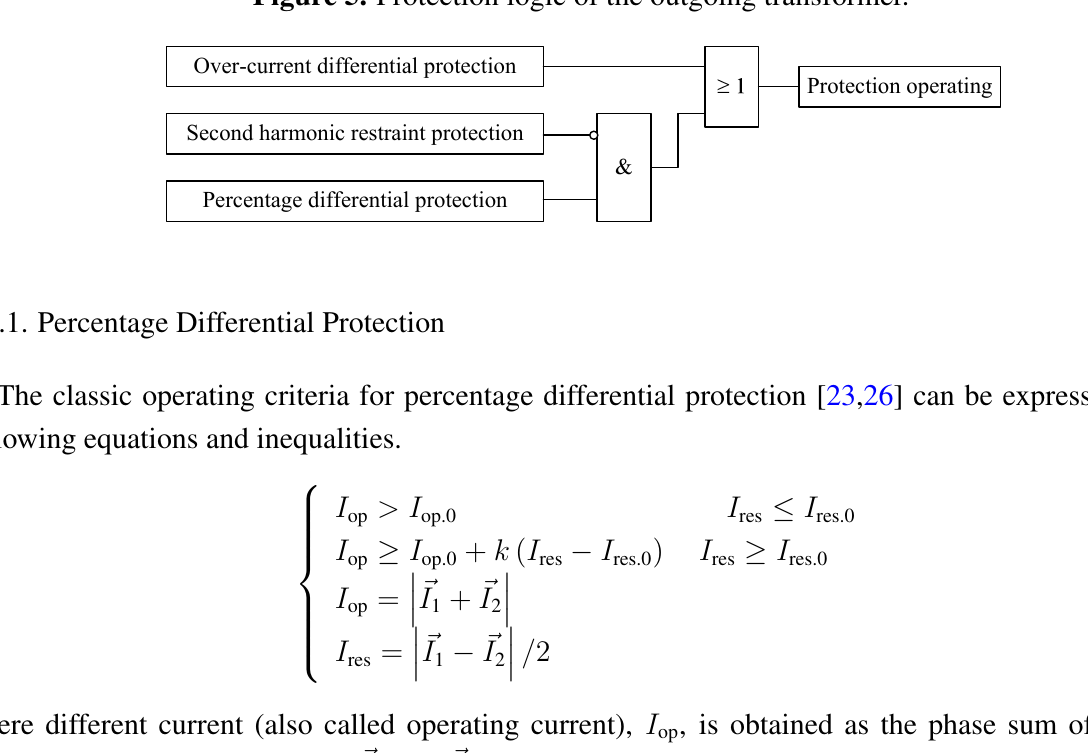
Figure 5. Protection logic of the outgoing